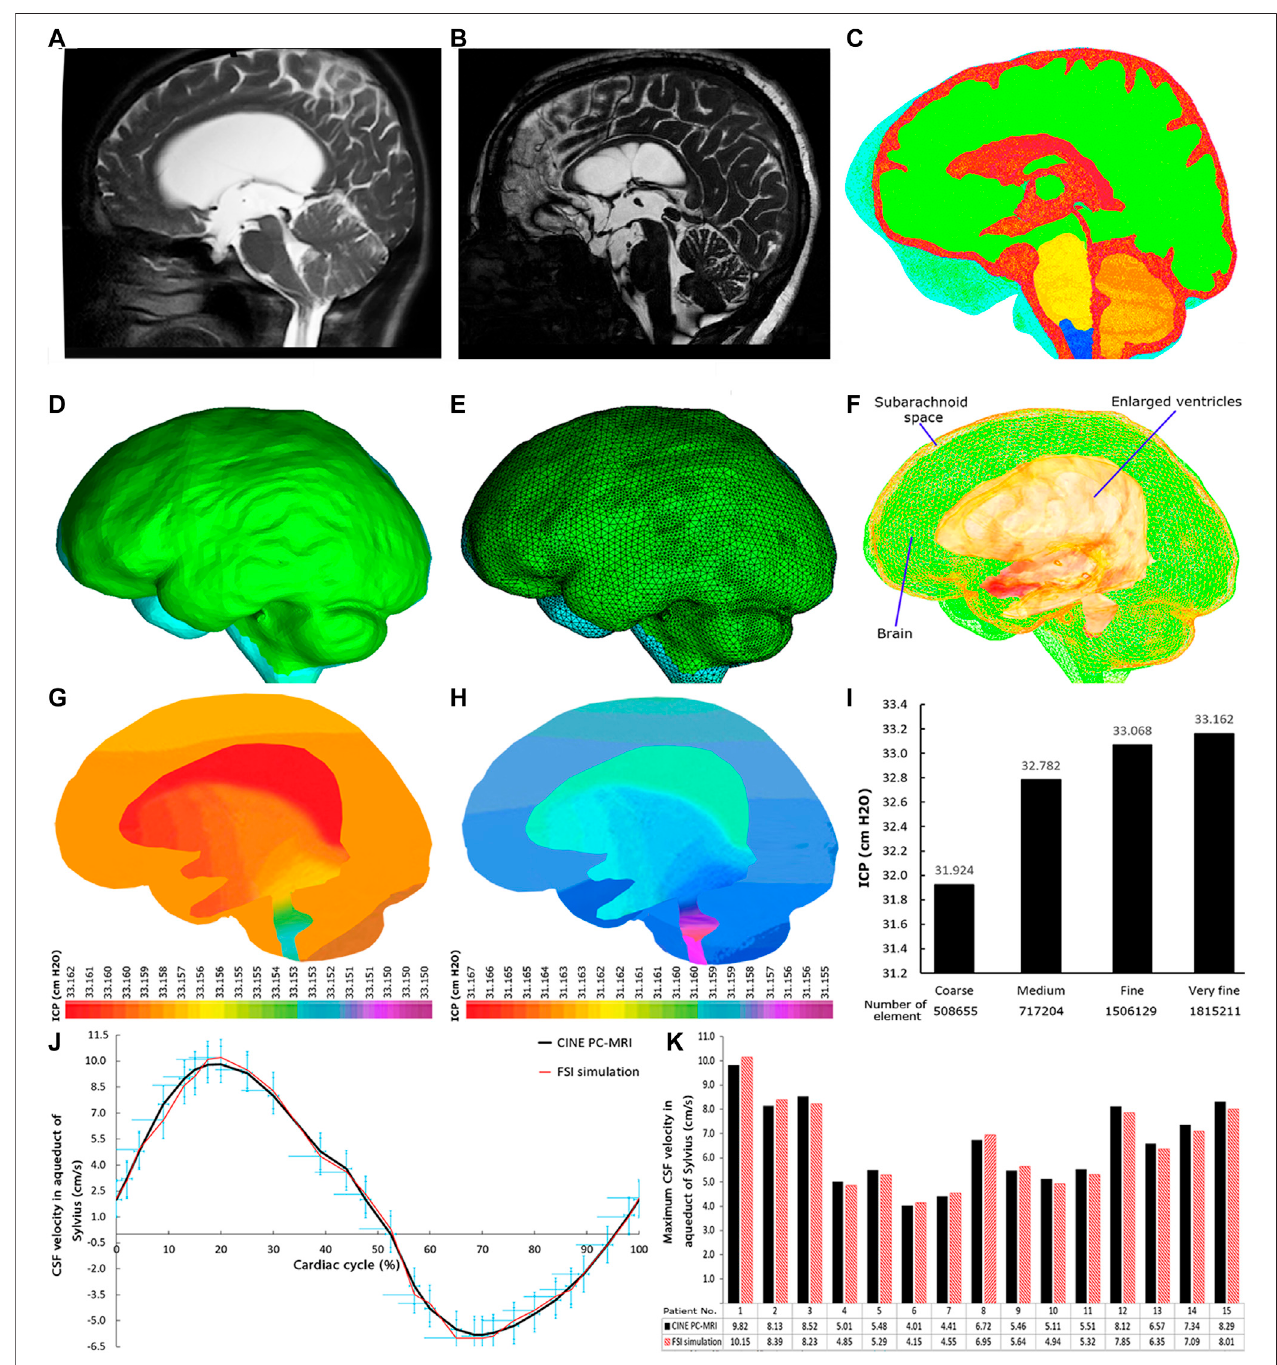
FIGURE 2 | MRI, 3D geometrical model, meshed model, FSI simulation, grid independence study, and data validation. (A) and (B) show MRI of patient No. 2 pre- shuntingand12 monthsaftershunting,respectively. (C) showstheheadsubstructuresinpatientNo.218 monthsaftershunting.Theredandgreenareasshowthe fl uid (ventricular system and subarachnoid space) and solid (brain tissue) domains, respectively. The borders and interfaces between red and green areas are FSI boundary conditions. (D) and (E) showthe3DgeometricalmodelandmeshedmodelofpatientNo.2priortoshunting,respectively. (F) showsthemethodologicalwork fl ow. (G) and (H) show twosnapshots of ICP distribution at early systole and diastole phases, respectively, forpatientNo. 2pre-shunting. (I) The grid independence study for themaximumICPdata.Thedifferencebetween fi neandvery fi nemeshesininpatientNo.2priortoshuntingwas0.28%. (J) ThecomparisonofCSFvelocitygraphsinthe aqueductofSylviusbetweenCINEPC-MRIandFSIsimulationdatainacardiaccycleforpatientNo.1. (K) ThecomparisonofthemaximumCSFvelocityintheaqueduct ofSylvius between CINE PC-MRI and FSI simulation data forall 15patients.CSF: cerebrospinal fl uid; FSI: fl uid – structure interaction; CINE PC-MRI: cinephase-contrast magnetic resonance imaging; and ICP: intracranial